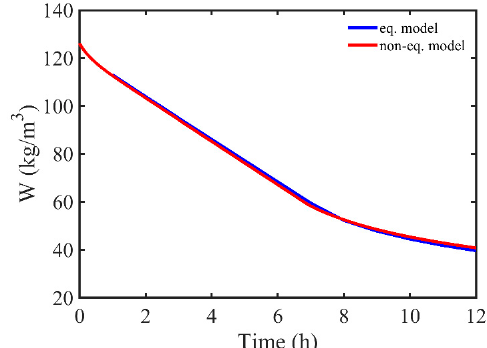
Figure 5. Comparison of temporal variations of the volumetric moisture content predicted with non- equilibrium and equilibrium models, at the surface and inside the dried brick, at a distance of 1 and 2 cm from the surface.